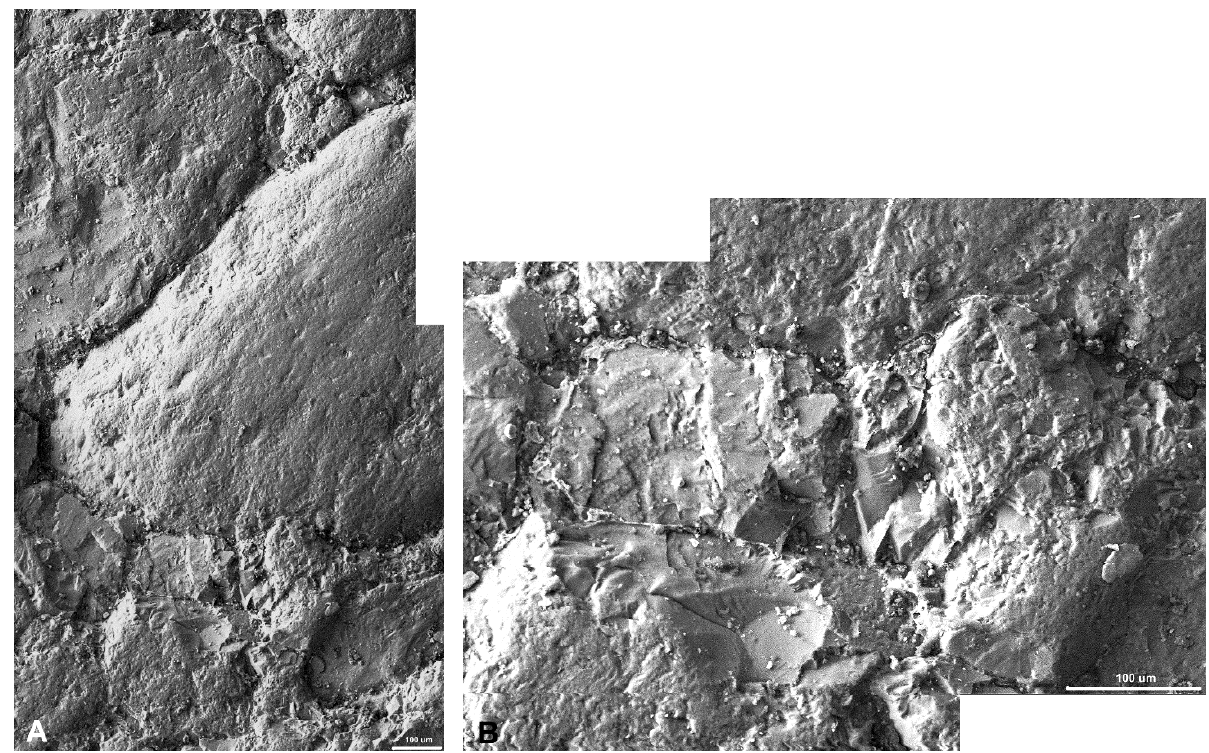
Figure 3. (A) Battering fracture patterns on quartz grains and former zones of colloid silica; (B) Close-up of two such zones, showing the complete conversion to crystalline quartz.